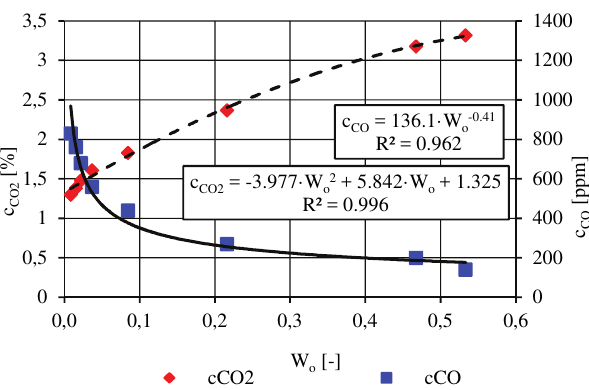
Fig. 5. The concentration of carbon monoxide (c CO ) and the concentration of carbon dioxide (c CO2 ) in the LM 2500 1A engine exhaust as a function of the engine load factor (W o )